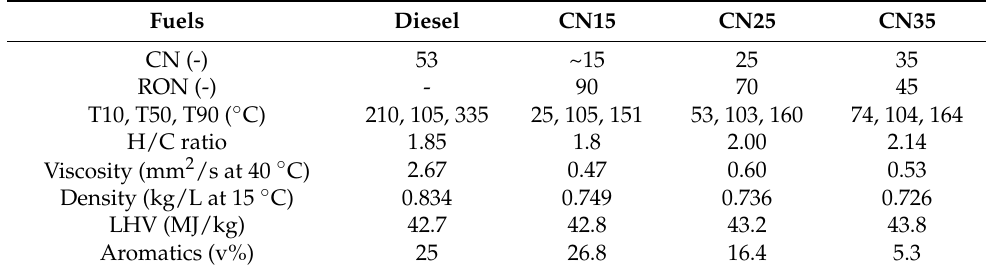
Table 1. Summary of fuel properties.